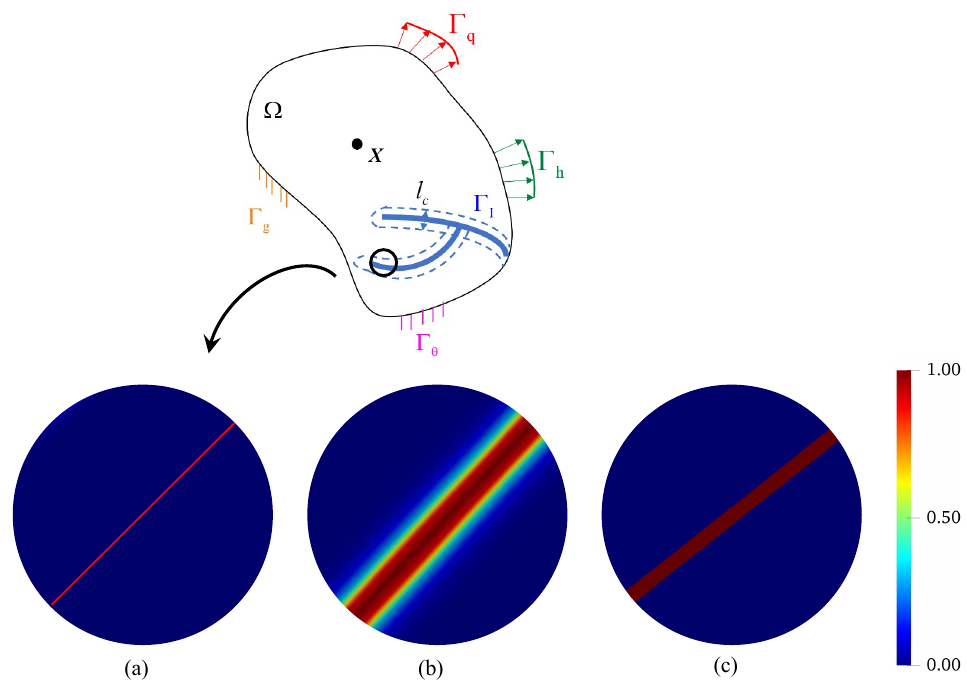
Figure 2. Crack evolution of proposed phase field method in the thermal field: ( a ) actual crack; ( b ) crack description in the phase field method; ( c ) crack description under trigger parameter A